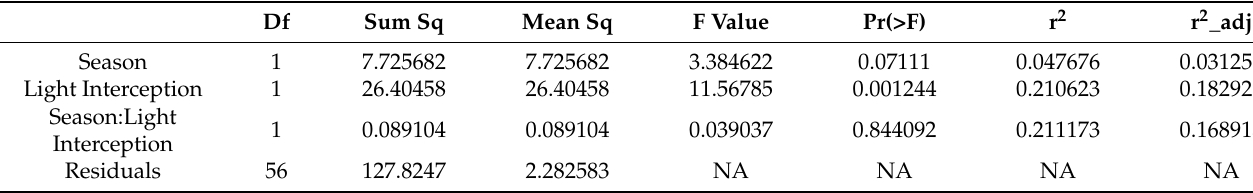
Table A16. Total soluble solid content.